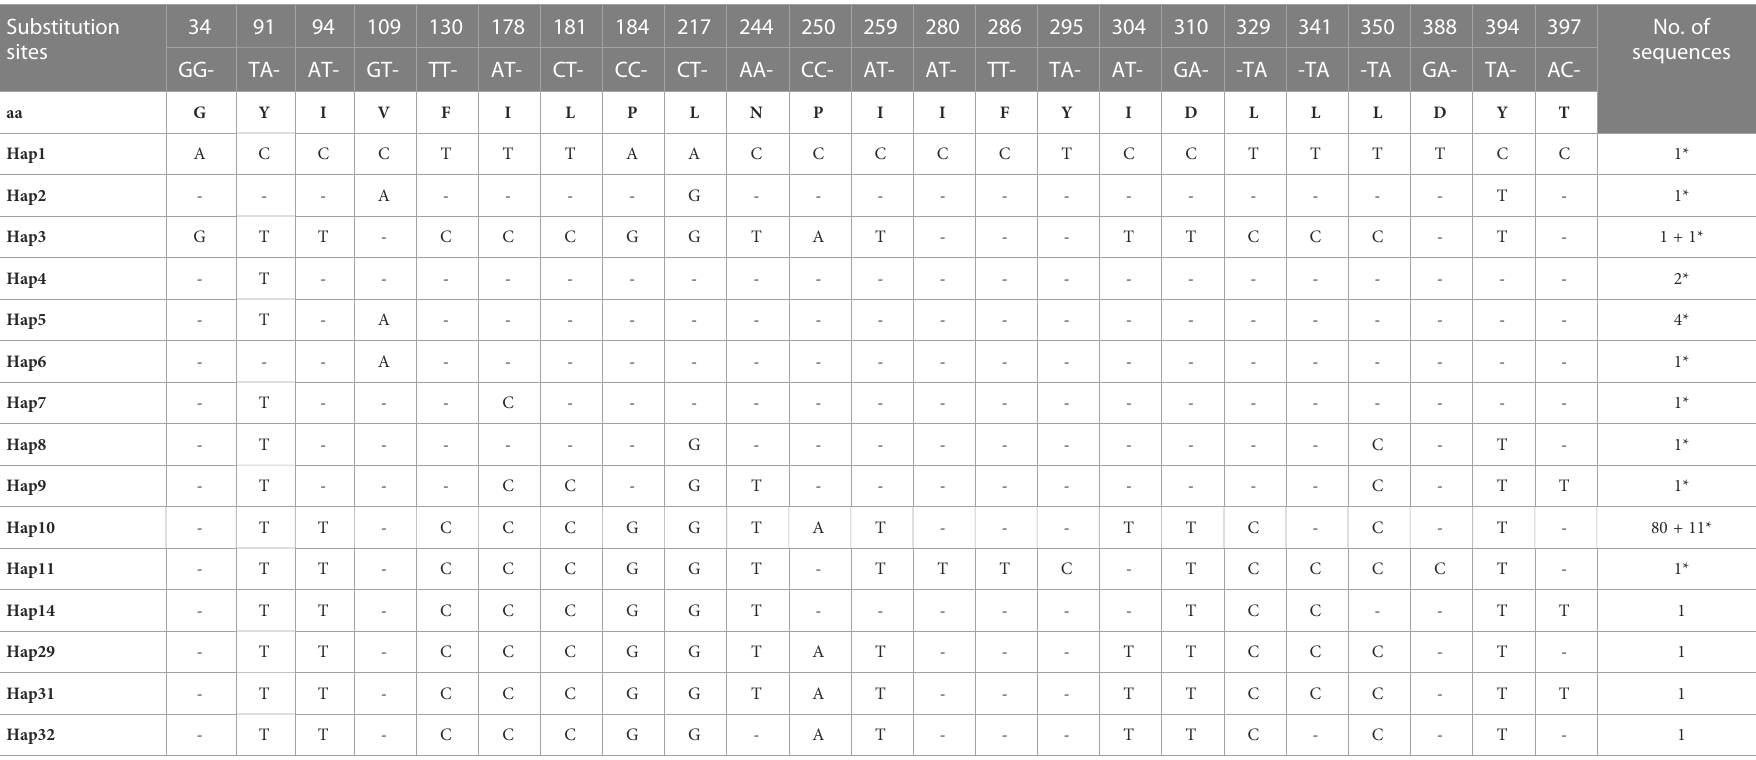
TABLE 2 Haplotypes identi fi ed in the 421bp mitochondrial cytb gene sequences, along with sample size. Substitution sites